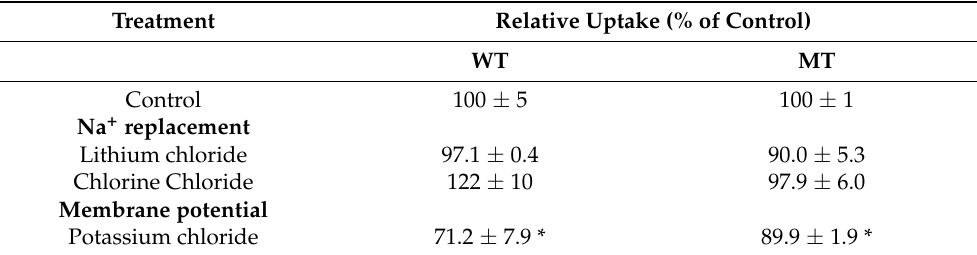
Table 2. Sodium-dependency and membrane potential effects on the uptake of [ 3 H]L-arginine by ALS cell lines.